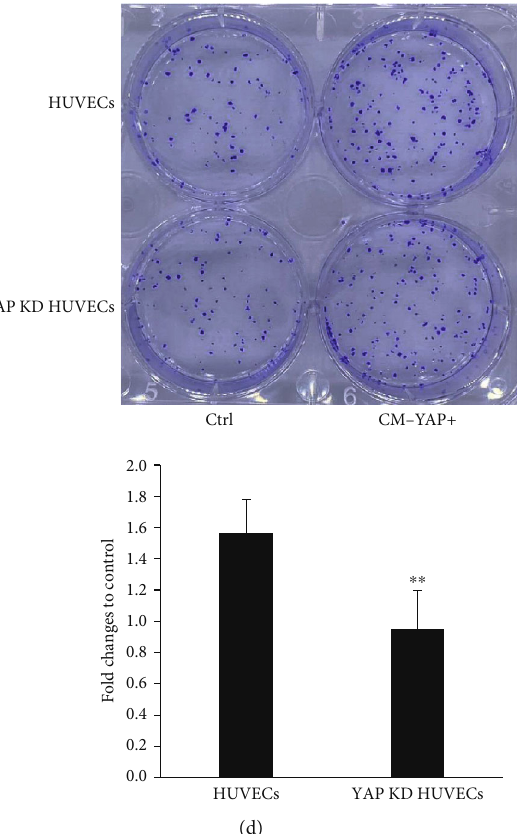
Figure 2: YAP expression in HUVECs involved in mediating CM-YAP+ induced tube formation, migration, and proliferation of HUVECs. (a) HUVECs were transfected with YAP CRISPR/Cas9 KO plasmid (YAP KD), YAP expression was detected by Western blot. (b) After starved from FBS for 16 hr, HUVECs, and YAP knock down (KD) HUVECs were treated with di ff erent conditioned medium obtained from breast cancer cells for 12hr. The total segment length and total branching length are quanti fi ed with mean ± SD from six independent representative fi elds ∗ p < 0 : 05 , ∗∗ p < 0 : 01 . (c) Migration of HUVECs and YAP knock down HUVECs with di ff